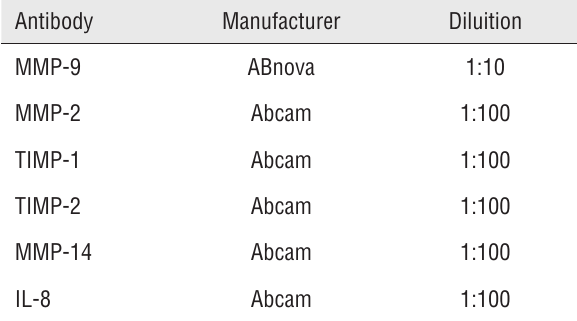
Table 2 - Antibodies utilized.